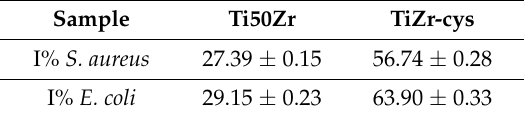
Table 3. The bacterial inhibition level of zwitterionic coating.